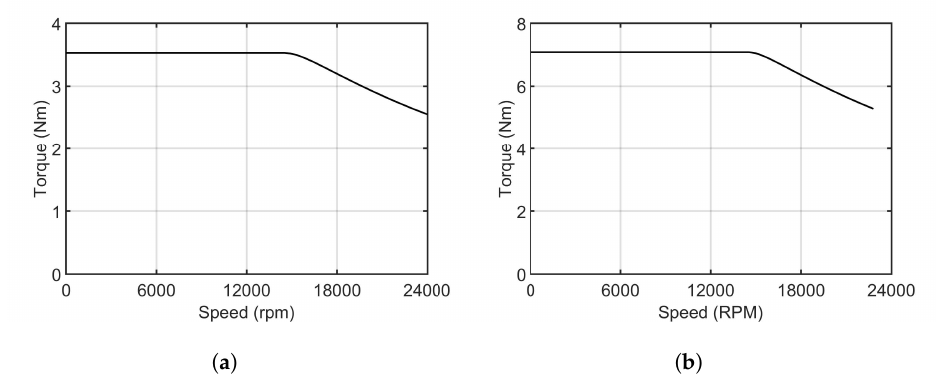
Figure 19. Torque-speed characteristics of the electric machine ( a ) One channel excited ( b ) Both channels excited. Table 3. Details of the EMA electric